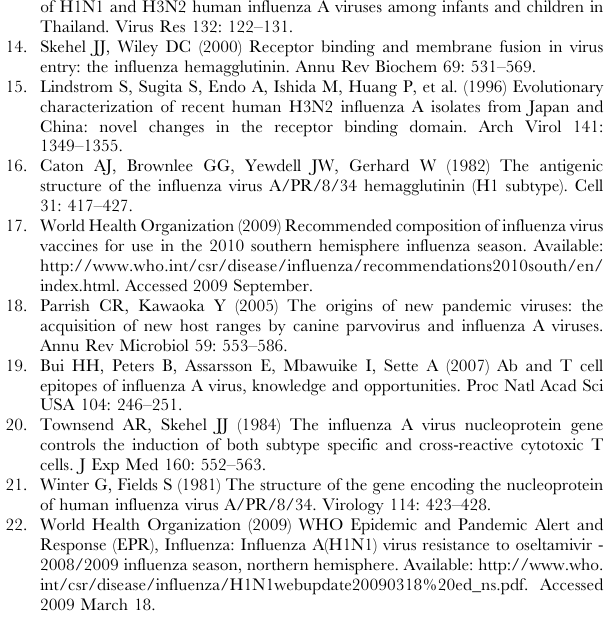
Table S1 Accession number of influenza virus that isolated from this study.